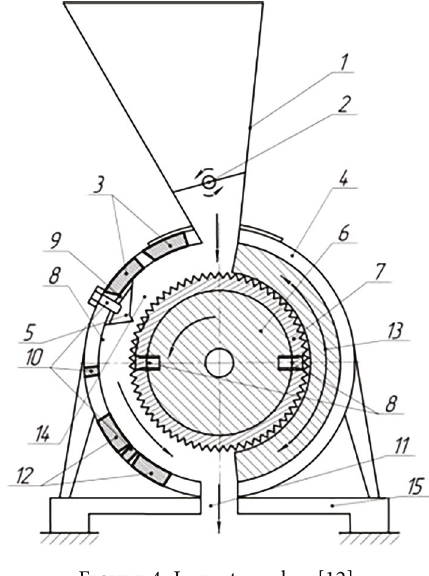
Figure 4: Impact crusher [12].